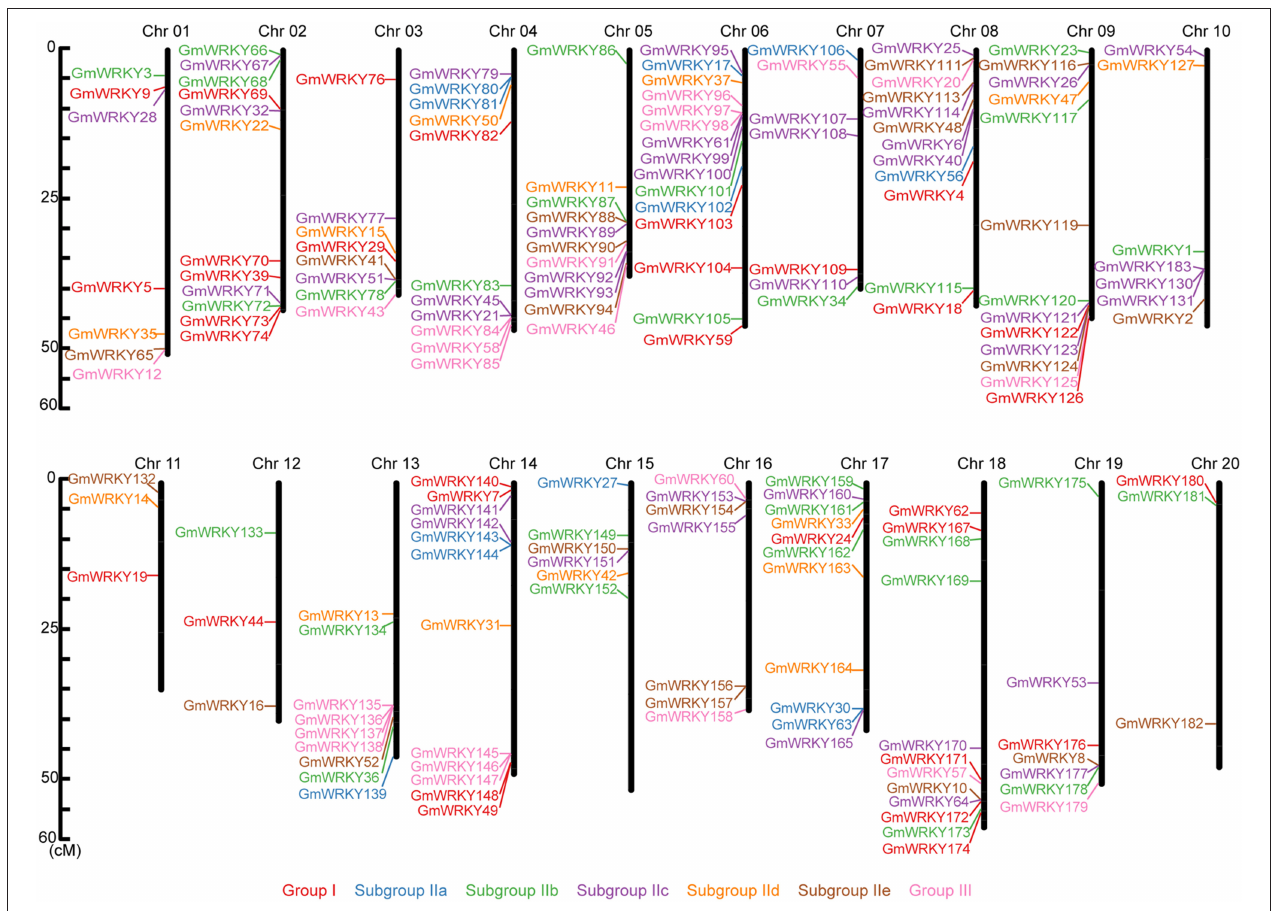
FIGURE 1 | Chromosomal location of GmWRKY genes. The chromosome numbers were shown at the top of each chromosome (black bars). The names on the left side of each chromosome correspond to the approximate location of each WRKY gene.